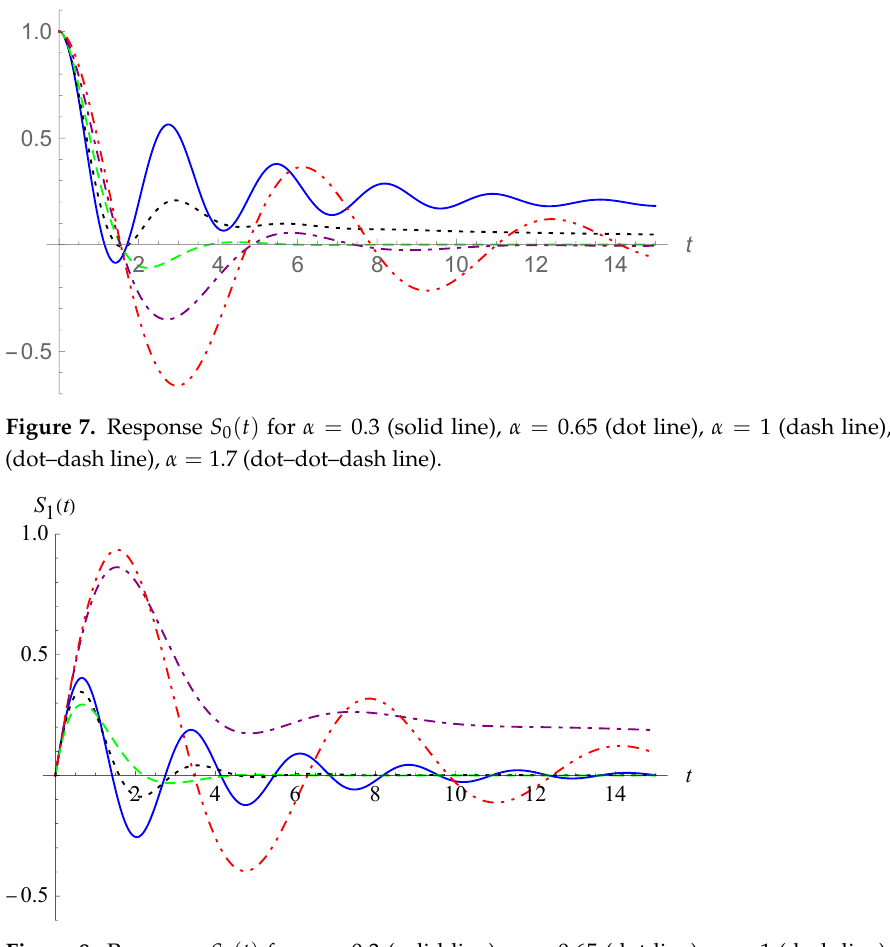
Figure 8. Response S 1 ( t ) for α = 0.3 (solid line), α = 0.65 (dot line), α = 1 (dash line), α = 1.35 (dot–dash line), α = 1.7 (dot–dot–dash